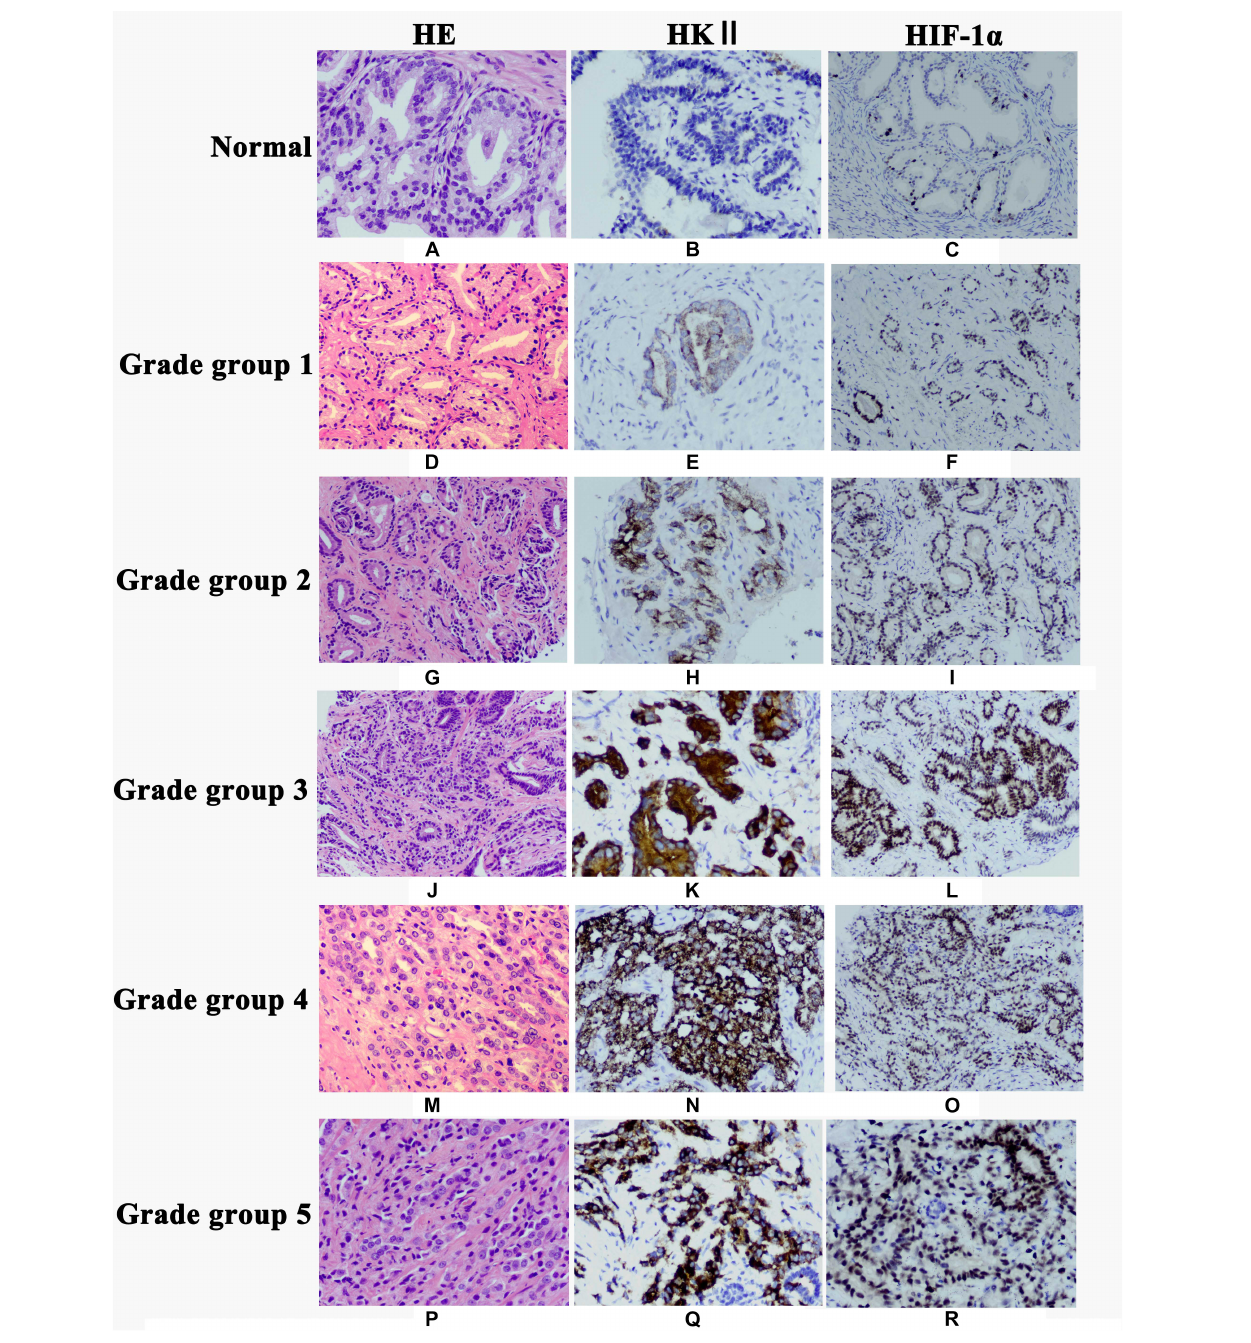
FIGURE 1 | Expression of HKII and HIF-1 α in normal prostate tissues, prostate cancer grade group 1, grade group 2, grade group 3, grade group 4 and grade group 5 detected by immunohistochemistry. Hematoxylin-eosin (HE) staining showed morphology of normal prostate tissues (A) , Grade group 1 (D) , Grade group 2 (G) , Grade group 3 (J) , Grade group 4 (M) and Grade group 5 (P) . HKII staining was undetectable in normal prostate tissues (B) . Immunoreactivity of HKII gradually increased from Grade group 1 (E) , Grade group 2 (H) , Grade group 3 (K) , Grade group 4 (N) to Grade group 5 (Q) . The expression of HIF-1 α gradually elevated from normal prostate tissues (C) , Grade group 1 (F) , Grade group 2 (I) , Grade group 3 (L) , Grade group 4 (O) to Grade group 5 (R)